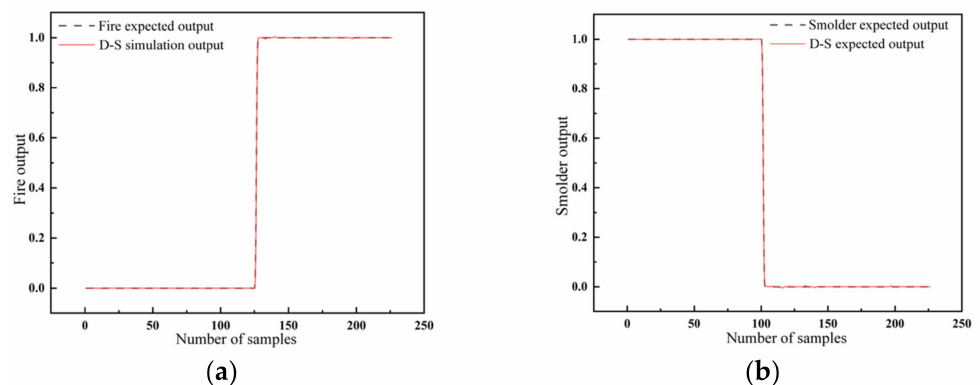
Figure 12. Comparative results of the D-S evidence theory fusion approach: ( a ) expected fire output and simulation outputs; ( b ) desired smolder output and simulation outputs.